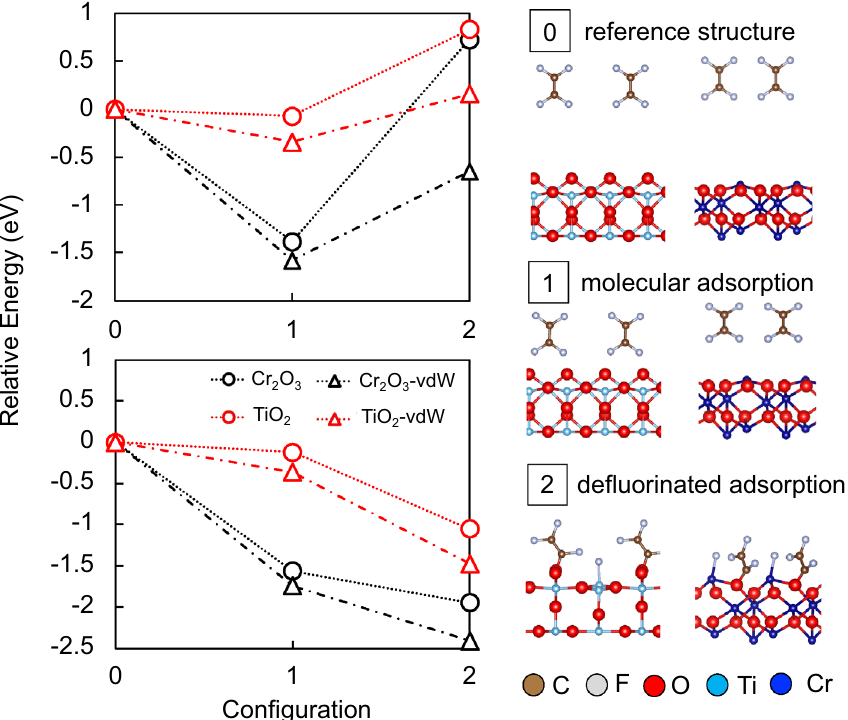
Figure 1. TFE on TiO 2 (110) and Cr 2 O 3 (0001) in 3 different configurations, viz., reference structure (0), molecular adsorption (1), and defluorinated adsorption (2) on the corresponding surfaces. Upper panel corresponds to the relative energies of optimized adsorbates on frozen surfaces. Lower panel corresponds to the relative energies with surface relaxation. (Note stronger TFE adsorption on Cr 2 O 3 (0001) than on TiO 2 (110), having retained energy trend after implementing van der Waals (vdW)